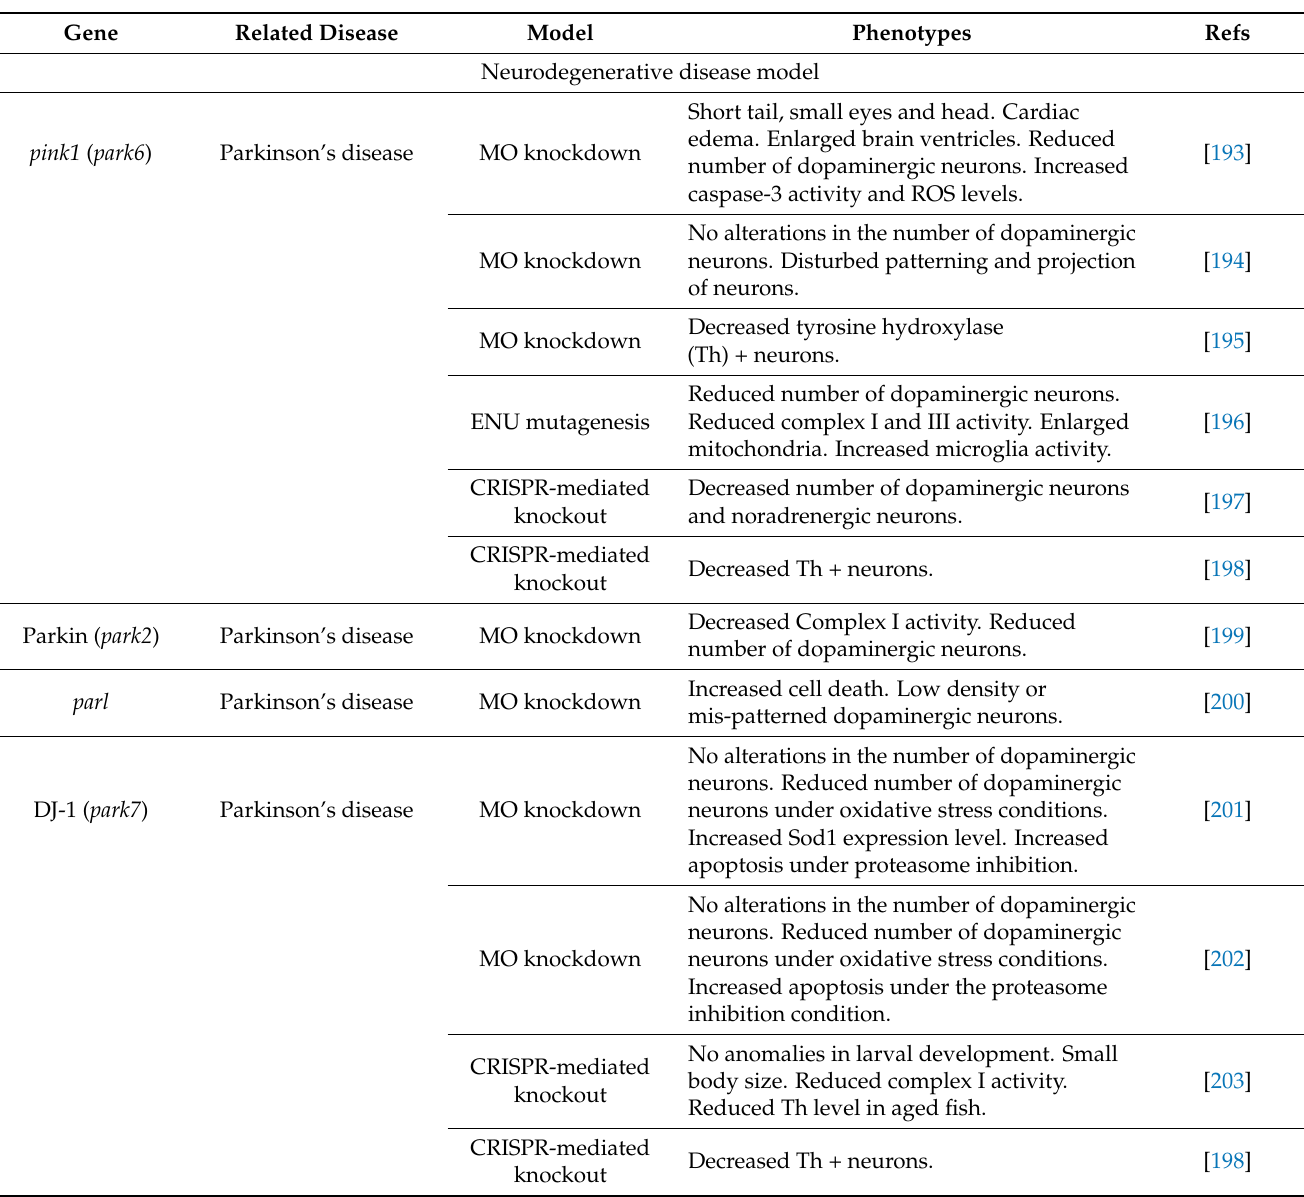
Table 1. The characteristics of loss or gain of function studied in zebrafish for mitochondrial-related